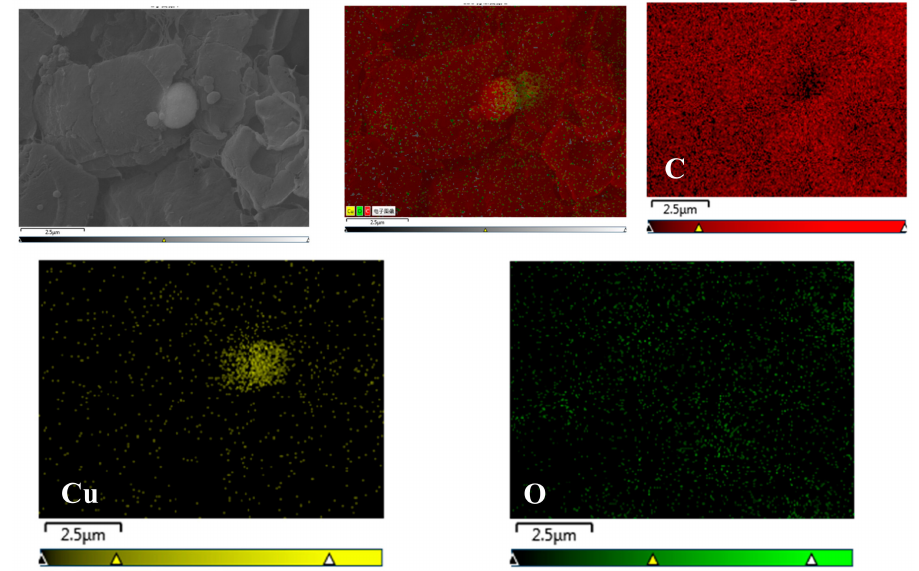
Figure 6. SEM images mapping of M-Cu 2 O / PP composites, EDS / SEM mapping for elements C, Cu and